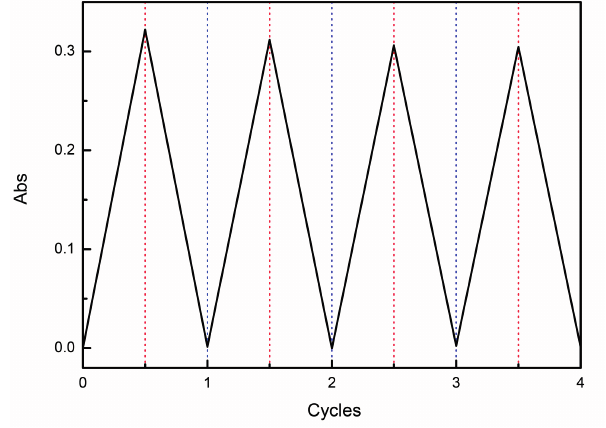
Figure 6. Redox switching of the [2]rotaxane 1 in CH 3 CN (0.3 mM), monitored at 829 nm using UV spectroscopy. Each switching cycle involved sequential addition of NOBF 4 (70 µg) and Zn powder (20 mg), followed by